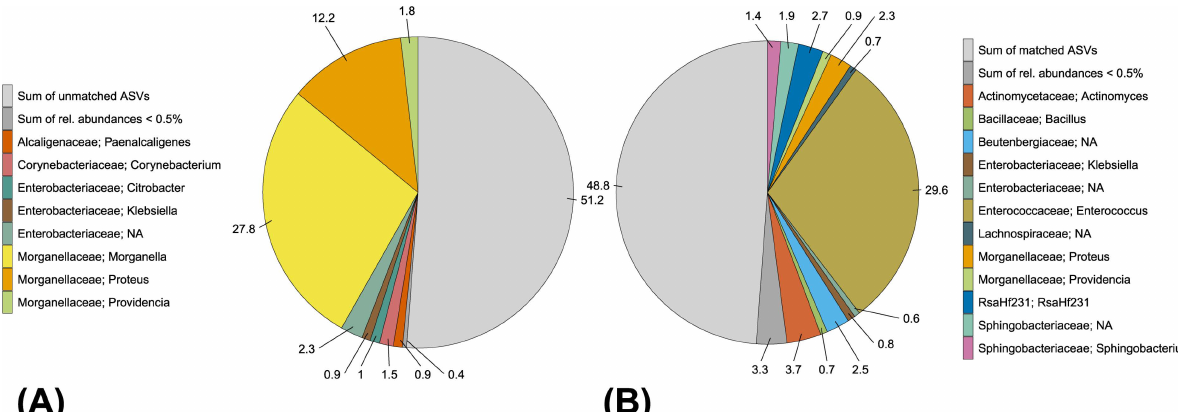
Figure 8. Bacterial composition at the genus level in the amplicon data depending on ASVs matching or not matching Sanger sequences with 100% identity. Numbers indicate percent relative abundance. Genera with <0.5% relative abundance are consolidated. ( A ) Distribution of 23 ASVs aligned to 92 Sanger sequences (matched). ( B ) Distribution of 185 ASVs not aligned to our Sanger sequences